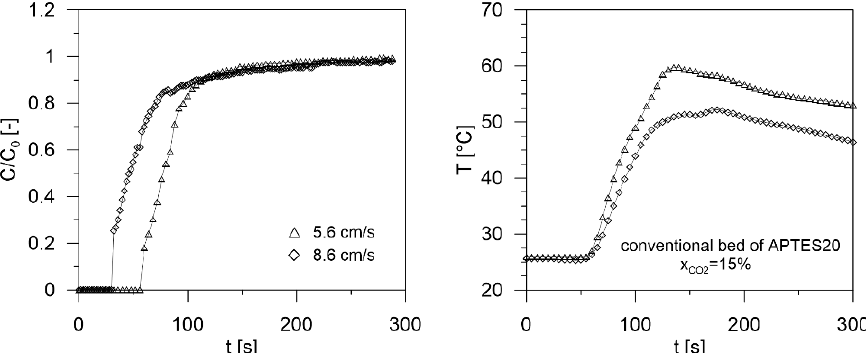
Figure 13. Effect of gas velocity on the breakthrough curves for APTES20 in conventional bed with 15% CO 2 .